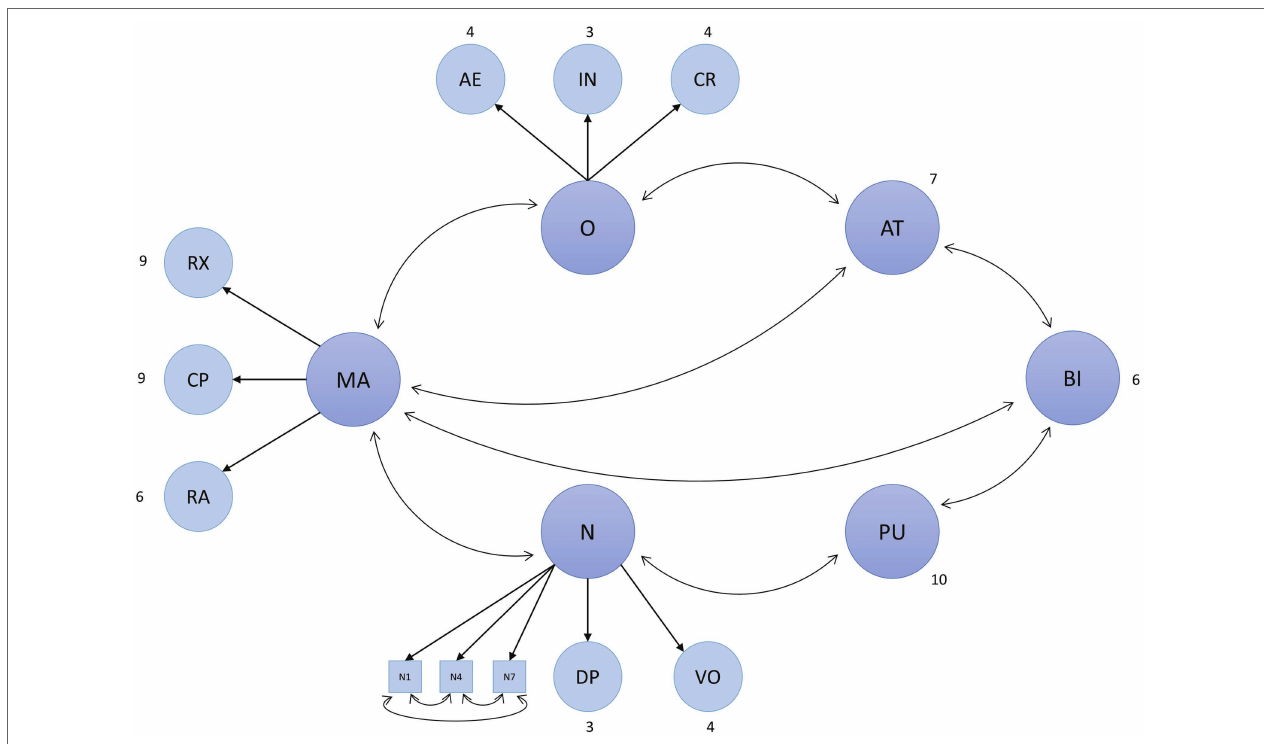
FIGURE 5 | Adjusted CFA model. AE, aesthetic interest; AT, attitude toward using MSS; BI, intention to use MSS; CP, cognitive problem solving; CR, creative imagination; DP, depression; FE, fear; IN, intellectual curiosity; MA, modulation of negative affect through music; N, neuroticism; O, openness; PU, perceived usefulness of MSS; RA, reduction of negative activation; RX, relaxation; and VO, emotional